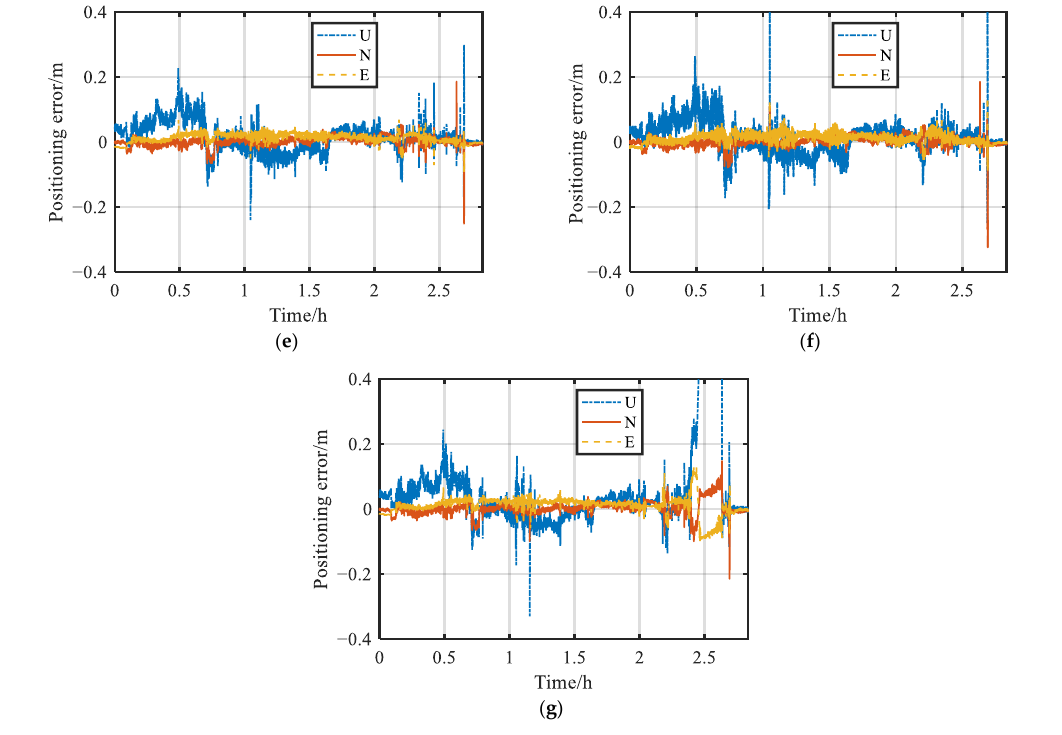
Figure 10. Position errors of different schemes: ( a ) Scheme 1; ( b ) Scheme 2; ( c ) Scheme 3; (d) Scheme 4; ( e ) Scheme 5; ( f ) Scheme 6; ( g ) Scheme 7.